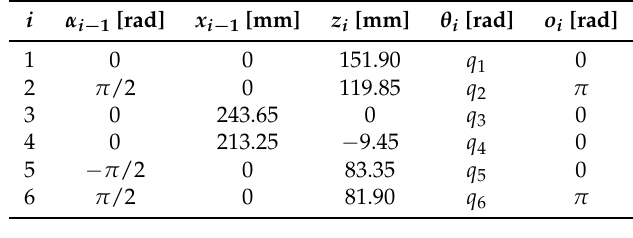
Table 1. MDH parameters of the UR3 robot.